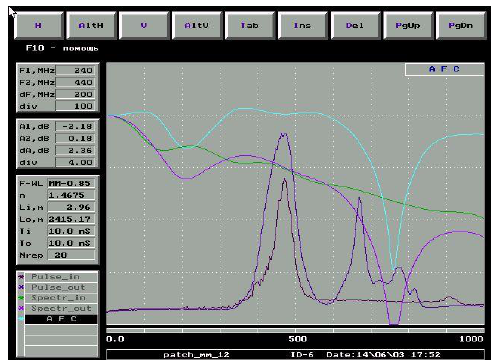
Figure 11. Software screenshot.